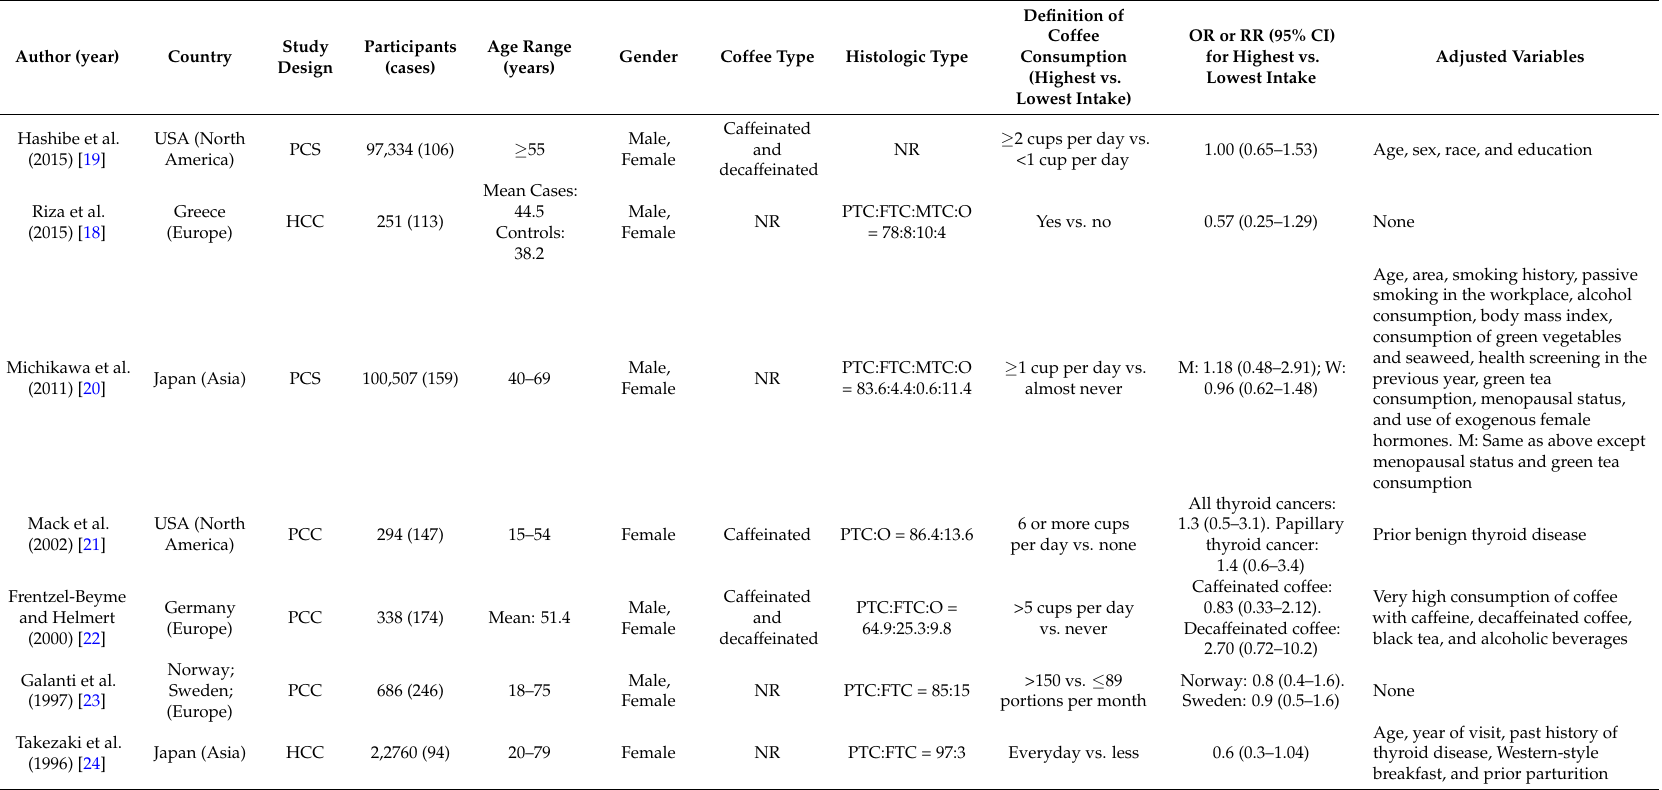
Table 1. Characteristics of studies on coffee consumption and thyroid cancer